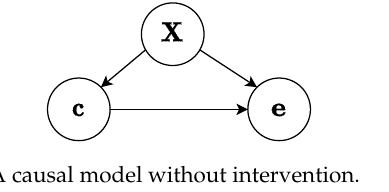
Figure 2. Our causal model with and without